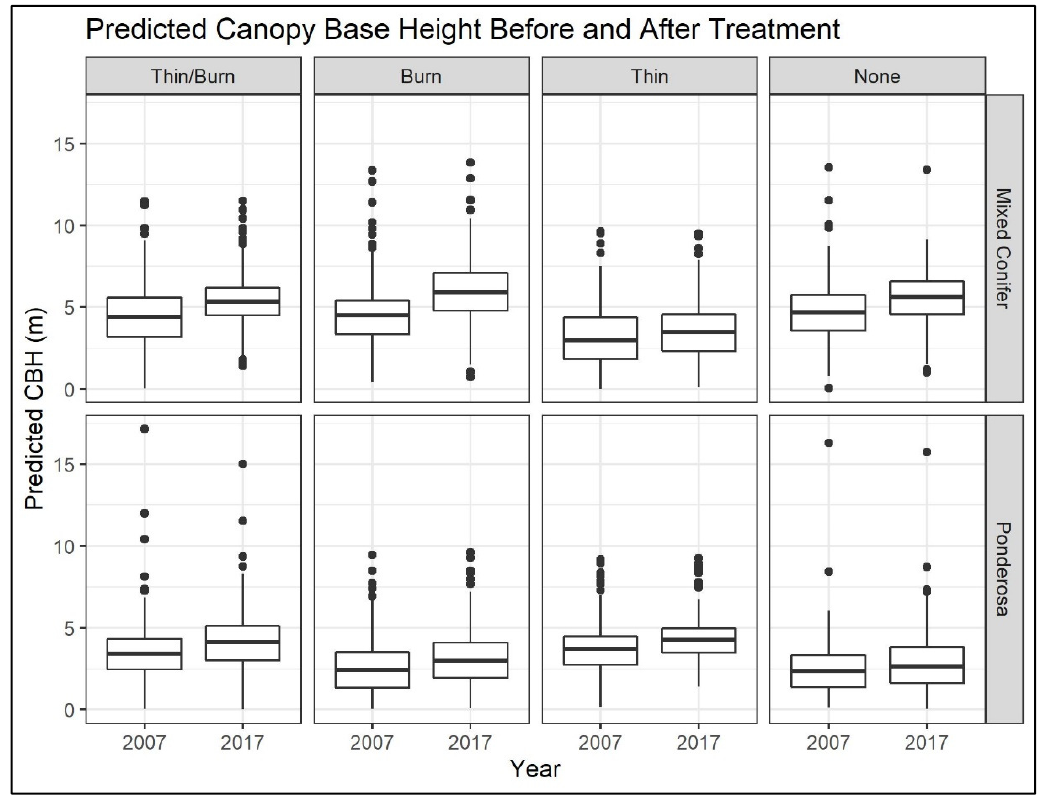
Figure 5. Predicted CBH before and after treatment in all sample units; ponderosa pine and dry mixed-conifer forest types on the Malheur National Forest near John Day, OR, USA.